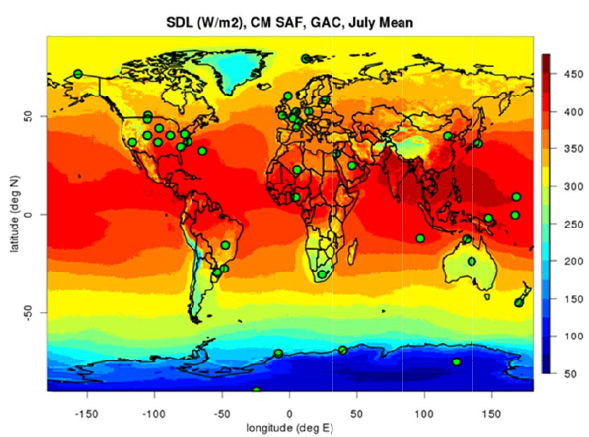
Fig. 12. Multi-year mean of July from the CLARA-A1 surface downwelling longwave [W m − 2 ] dataset. Green dots correspond to BSRN surface stations, where the CLARA-A1 SDL dataset fulfils the accuracy requirements of 10 W m − 2 for monthly